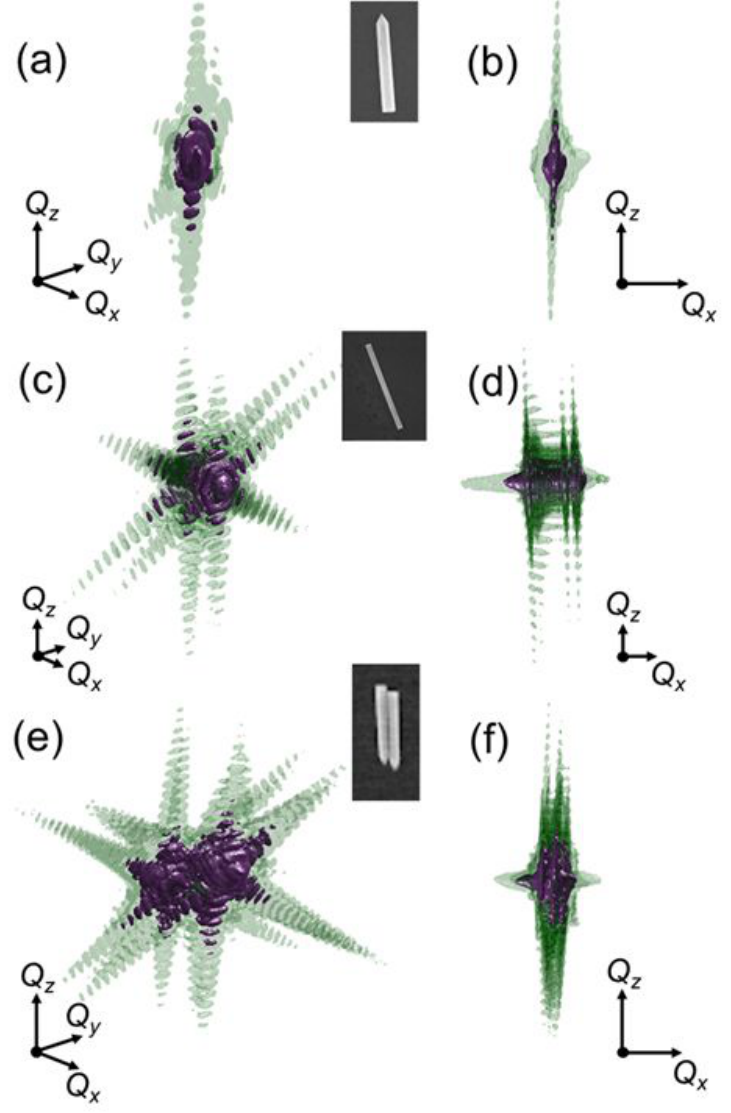
Figure 4. The intensity distribution around 10¯10 GaN Bragg reflection of free-lying GaN NWs shown from two different views to emphasize the diffraction pattern details. ( a – d ) Single GaN NWs with the diameters of 350 nm ( a , b ) and 200 nm ( c , d ). The thinner 200 nm NW reveals a double Bragg peak structure due to its bending on the substrate (see text for details). ( e , f ) For a comparison, the intensity distribution of two NWs with the diameters of 350 nm lying close to each other form well separated Bragg peaks in reciprocal space. To enhance the diffraction pattern details, the intensity distributions are represented by two different iso-surfaces. The length of coordinate arrows corresponds to 0.1 nm − 1 . The intensity is normalized to the maximum and the iso-surface values are 10 − 3 and 10 − 4.5 ( a , b ), 10 − 0.5 and 10 − 1 ( c , d ), 10 − 0.5 and 10 − 1 ( e , f ). Further, a single, free-lying GaN NW with a smaller diameter of 200 nm was studied. Its intensity distribution is shown from two different directions in Figure 4c,d.